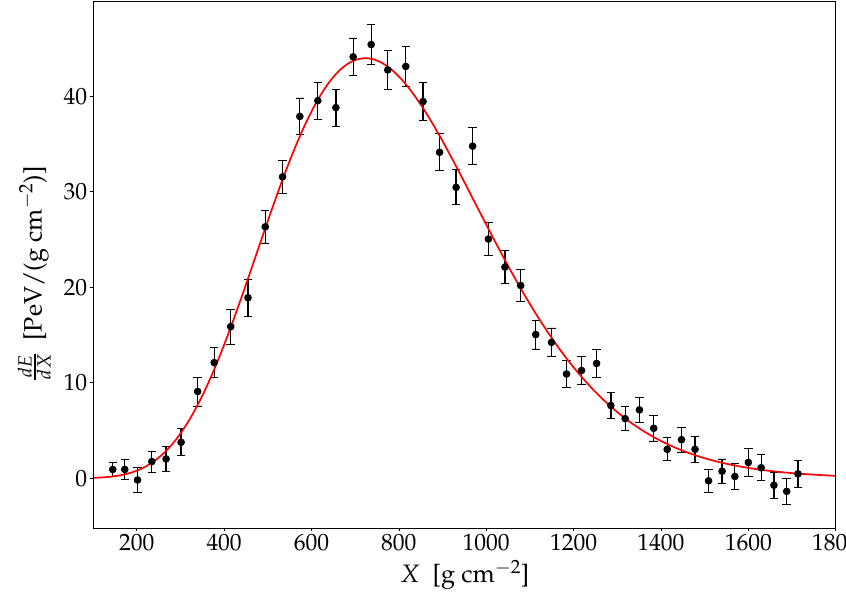
Figure 5. Hybrid event detected by the Pierre Auger Observatory. The solid line corresponds to a fit of the data points with a Gaisser–Hillas function (see Equation (14)). The primary energy of the event is E = ( 3.0 0.2 ) 10 19 eV and the maximum is reached at X max ∼ = 723 g cm − 2 . Adapted from ± ×